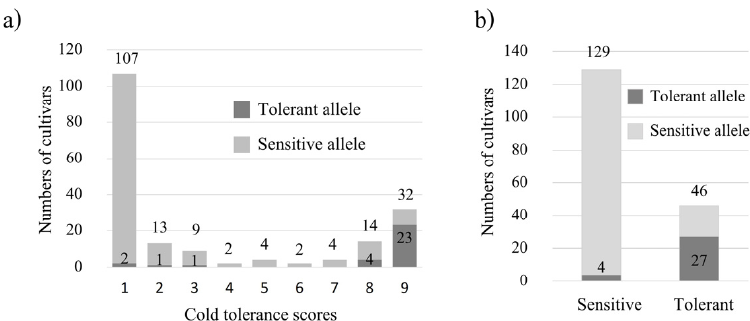
Figure 5. Genotyping using the three gene-specific markers and prediction of cold tolerance. ( a ) Allele frequency of the presence of one or more cold-tolerant allele from the three loci distributed in 1–9 cold tolerant scores of 187 rice accessions. ( b ) Allele frequency of the presence of one or more cold-tolerant allele from the three loci in extremely tolerant (score 8,9) and extremely sensitive (score 1–3) rice